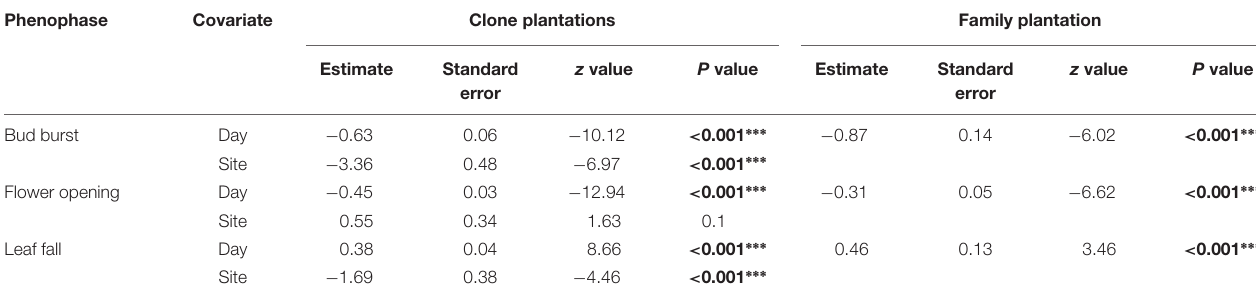
TABLE 5 | Model statistics for the phenological response variables in the clone plantations and the family plantation. Phenophase